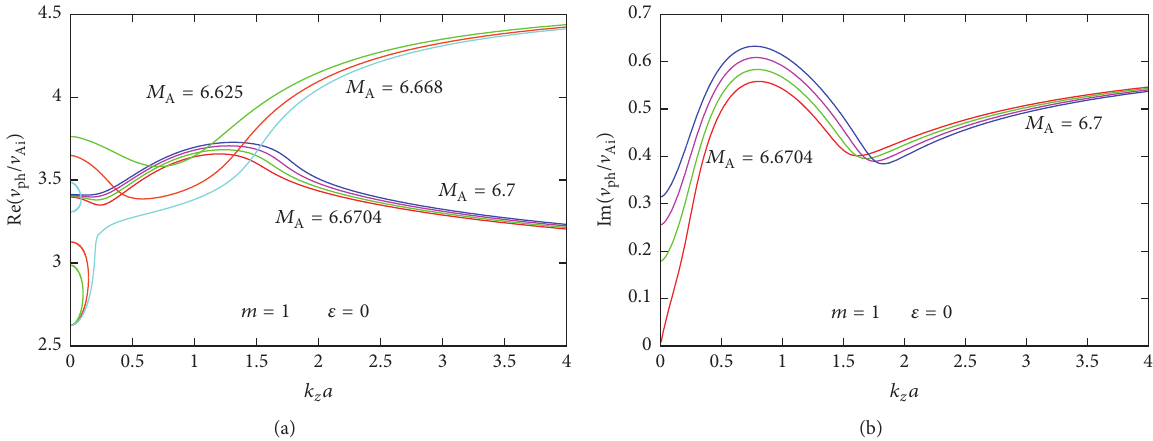
Figure 4: (a) Dispersion curves of stable and unstable kink ( 𝑚 = 1 ) MHD mode propagating in a moving untwisted magnetic flux tube of compressible plasma (modeling jet #8) at 𝜂 = 0.963 and 𝑏 = 4.56 . Unstable mode’s dispersion curves are pictured in the middle of the plot for = 6.6704 , 6.68 , 6.69 , and 6.7 . (b) The corresponding normalized growth rates of unstable modes for the same values of 𝑀 𝑀 A